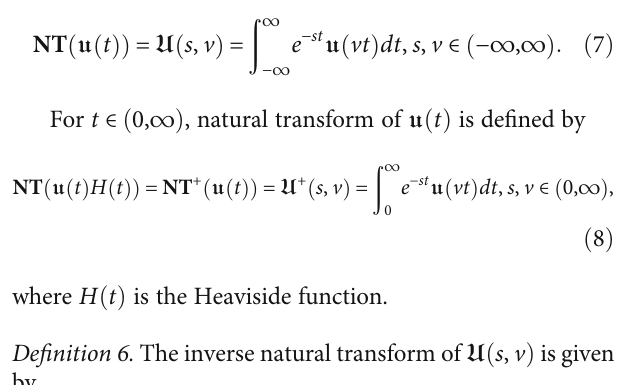
Table 2: Approximate solutions of NTDM x